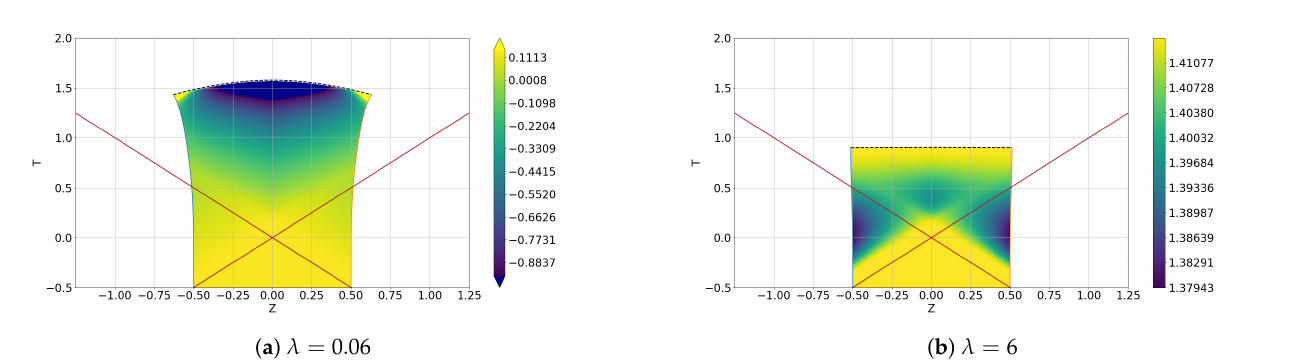
Figure 11. Penrose–Carter contour plots of the expansion rate H for the case of colliding waves with varying λ